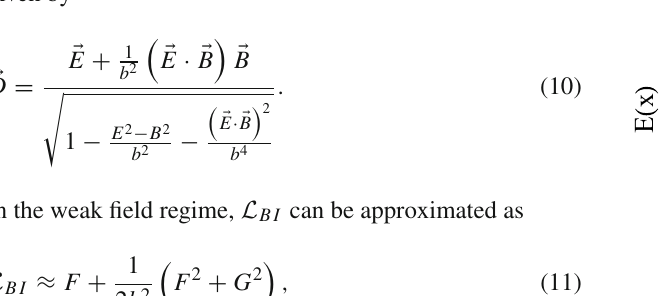
(cid:15) (cid:15) (cid:15) (cid:15) (cid:15) (cid:3) E (cid:15) = E in units Z 3 e